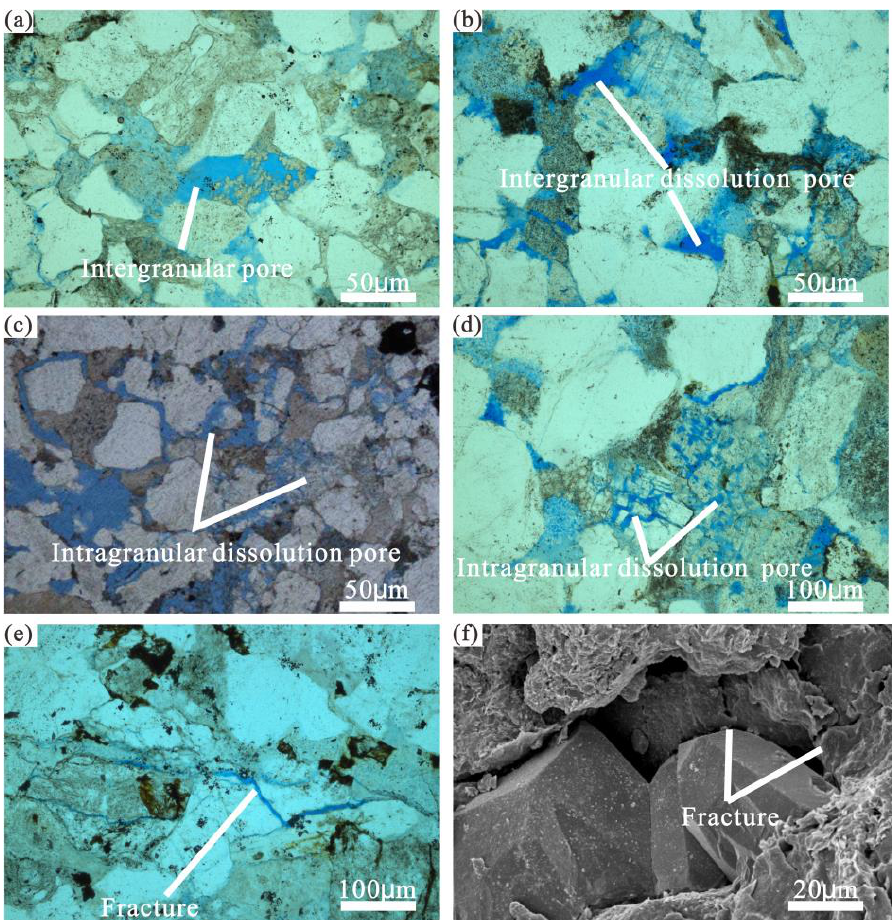
Figure 5. Space type of J 1 a sandstone from Dibei area. ( a ) YN5, 4931.82 m, intergranular pores; ( b ) YN2, 4845.8 mm, intergranular dissolution pores; ( c , d ) YN4, 4189.6 m, intragranular dissolution pores; ( e , f ) DB102, 5056.5 m, fractures.